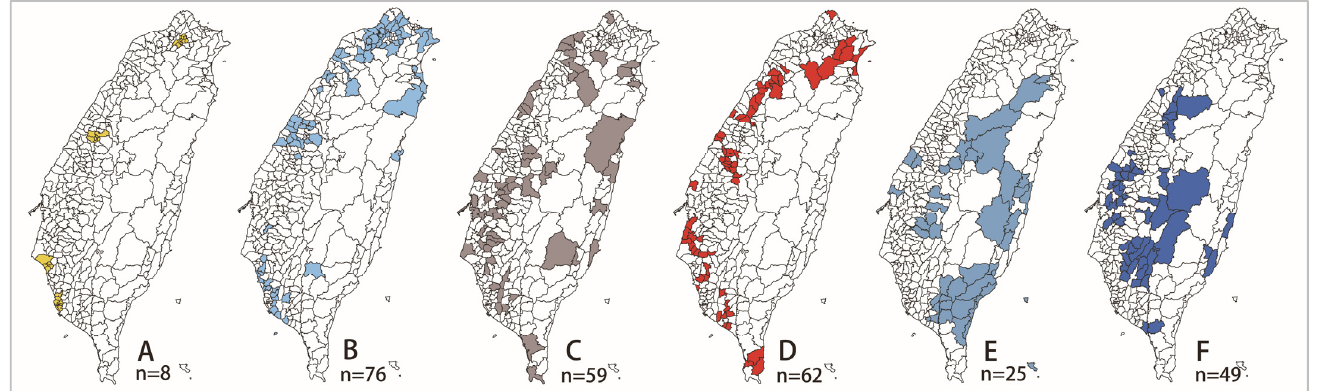
Figure 3. Spatial distribution of TLFAs in six clusters with three indicators—fuzzy C-means results. Note: A, B, C, D, E, and F represent the TLFAs clustering groups. Source: results obtained in this study from QGIS.